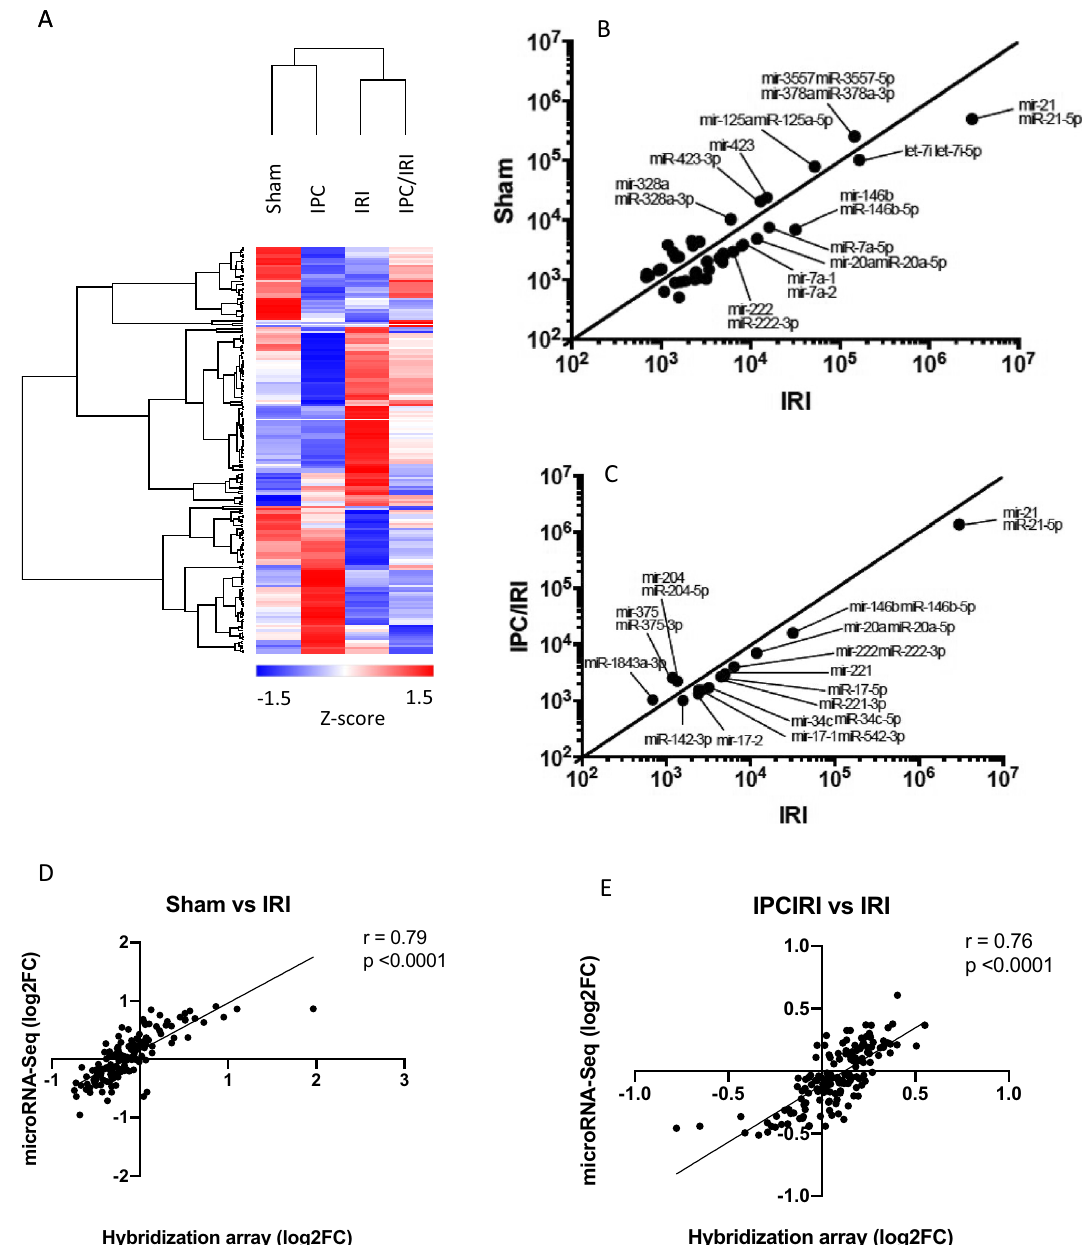
Figure 5. MicroRNA profiling (NGS and comparison with Microarray). Next Generation Sequencing (NGS) analysis of microRNAs from whole kidney tissue of bilateral sham, 45-min IRI, IPC alone, and IPC/IRI groups at 48 h after reperfusion. (A) Hierarchical clustering performed with GENE-E software (B,C) XY plots of (B) Sham versus IRI (C) IRI versus IPC/IRI. (D,E) Comparison of NGS and hybridisation array findings. Correlation plots comparing expression in NGS and Hybridization array datasets for (D) sham versus IRI and (E) IRI versus IPC-IRI